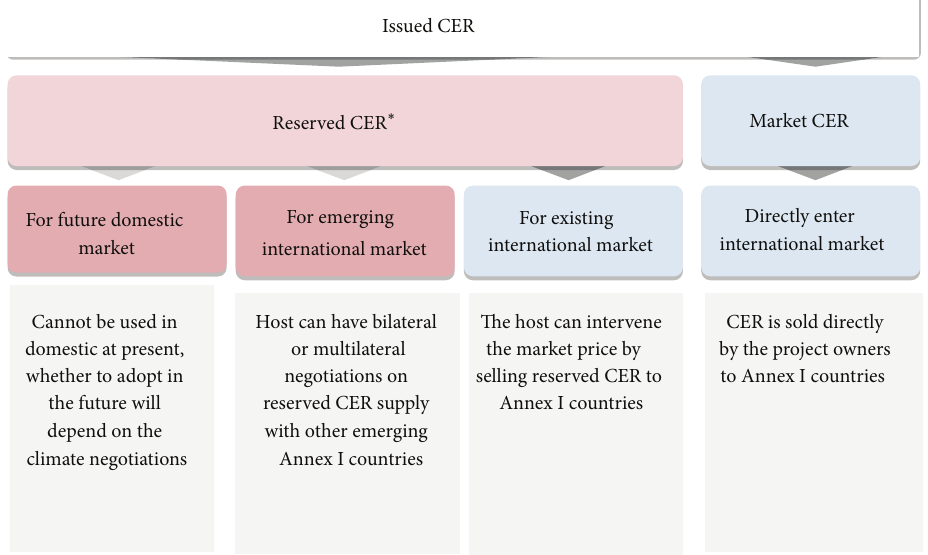
Figure 4: The scenario after implementation of this